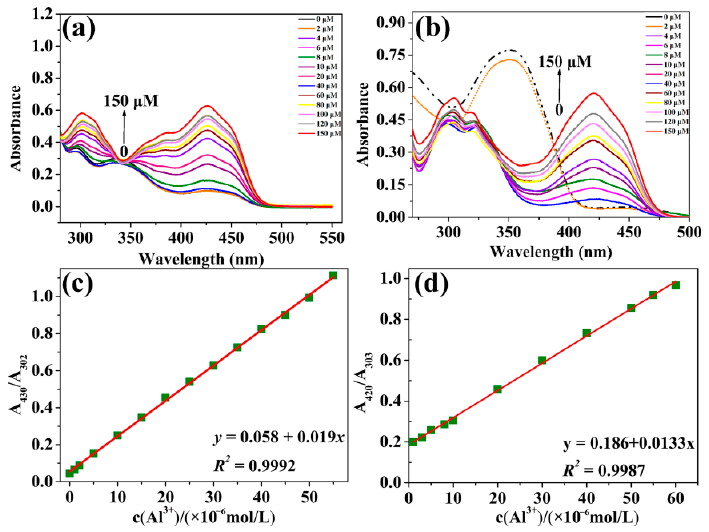
Figure 4. ( a , b ) UV spectra of L and S in the presence of increasing amounts of Al 3+ (0–150 μ M), re- spectively. ( c , d ) Plot of absorbance of L and S with Al 3+ concentration of 0–10 μ M in DMSO/H 2 O ( v : v = 8:2) solution, respectively. ( v : v = 8:2) solution,